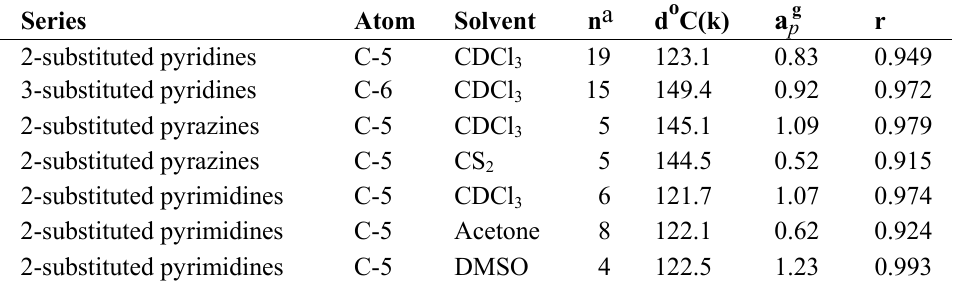
Table 3. Parameters of linear regressions (equation 3) of the chemical shifts of carbon atoms four bonds away from substituent with A Series Atom Solvent n a d